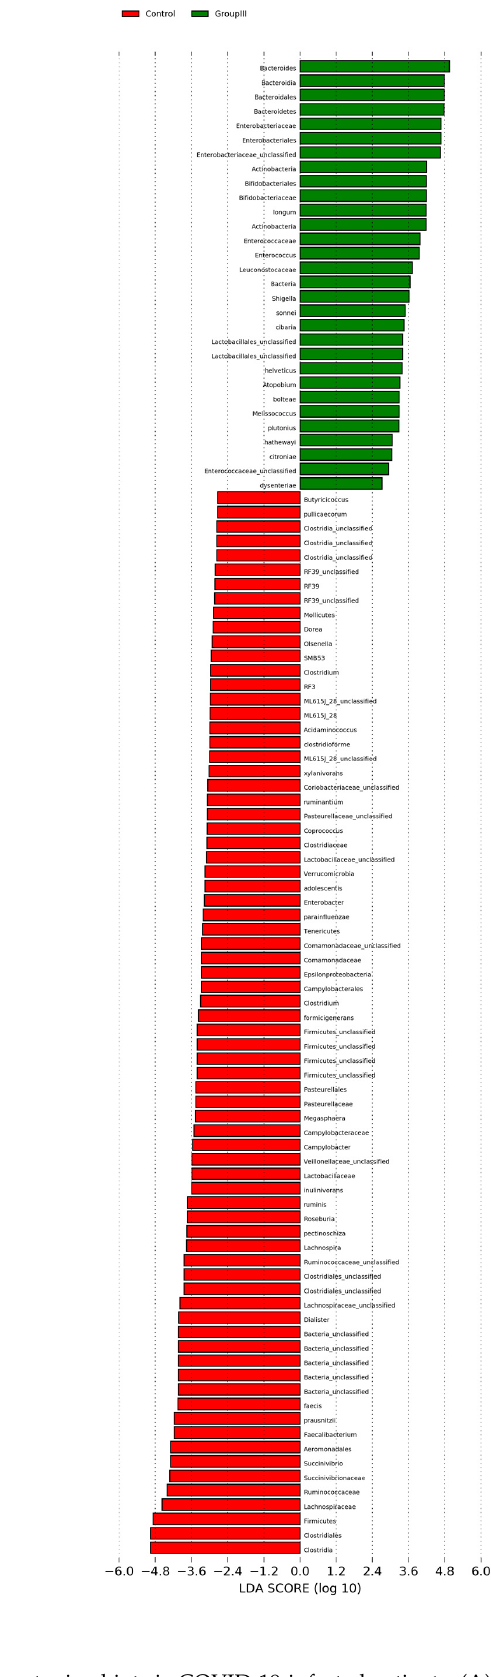
Figure 3. Cladograms and histograms showing the diversity of the gut microbiota in COVID-19-infected patients: ( A ) control vs. asymptomatic; ( B ) control vs. mild; ( C ) control vs.